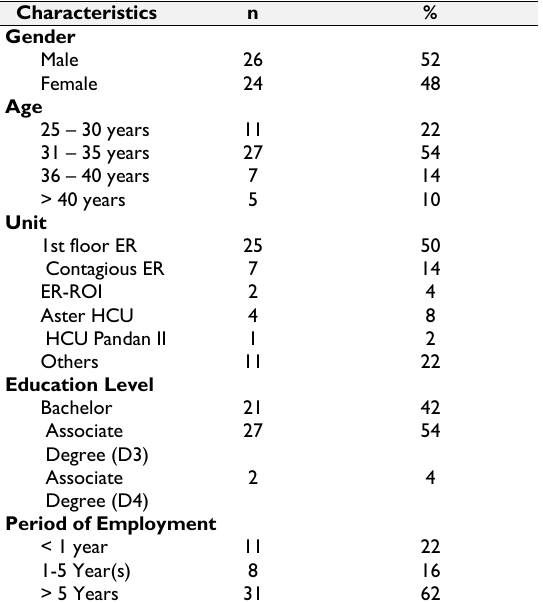
Table 1 BTCLS Training Participants Based on Age, Gender, Education, and Length of Work Characteristics